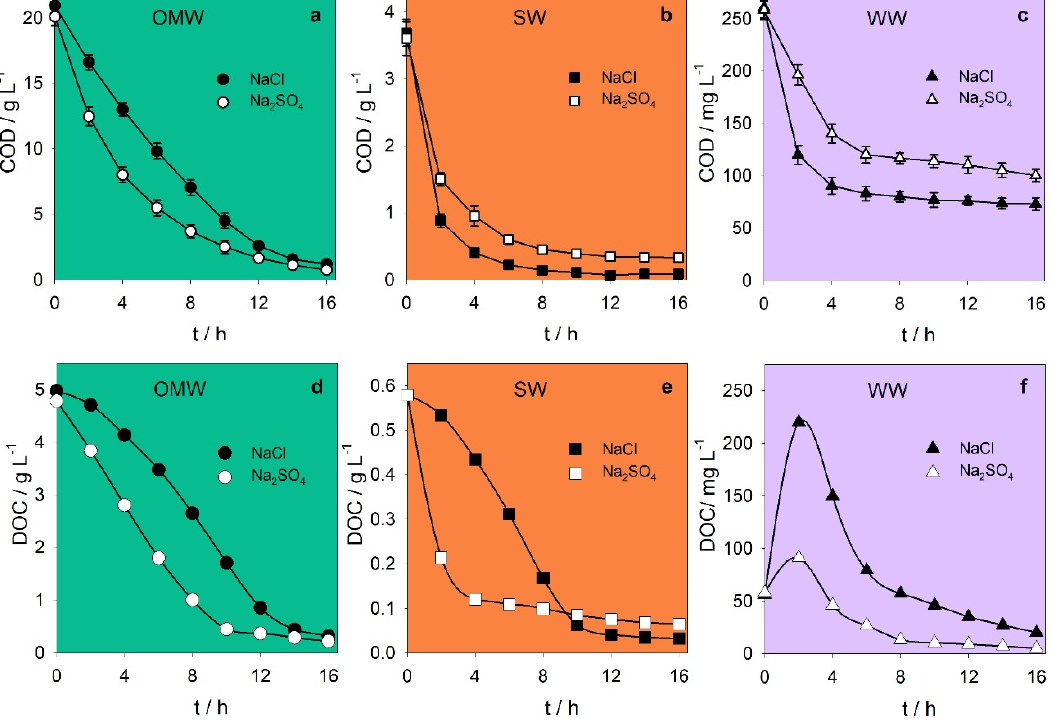
Figure 1. Chemical oxygen demand (COD) decay along the electrooxidation treatment of ( a ) Olive mill wastewater (OMW), ( b ) Slaughterhouse wastewater (SW), and ( c ) Winery wastewater (WW), utilizing NaCl or Na 2 SO 4 as supporting electrolyte. Dissolved organic carbon (DOC) decay for the same experiments with ( d ) OMW, ( e ) SW, and ( f ) WW.